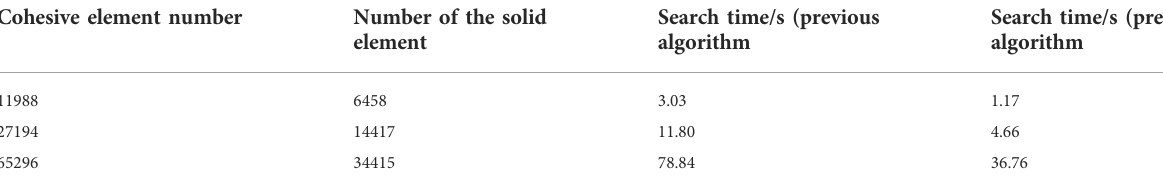
TABLE 1 Search times of the two fragment search algorithms for different element numbers.